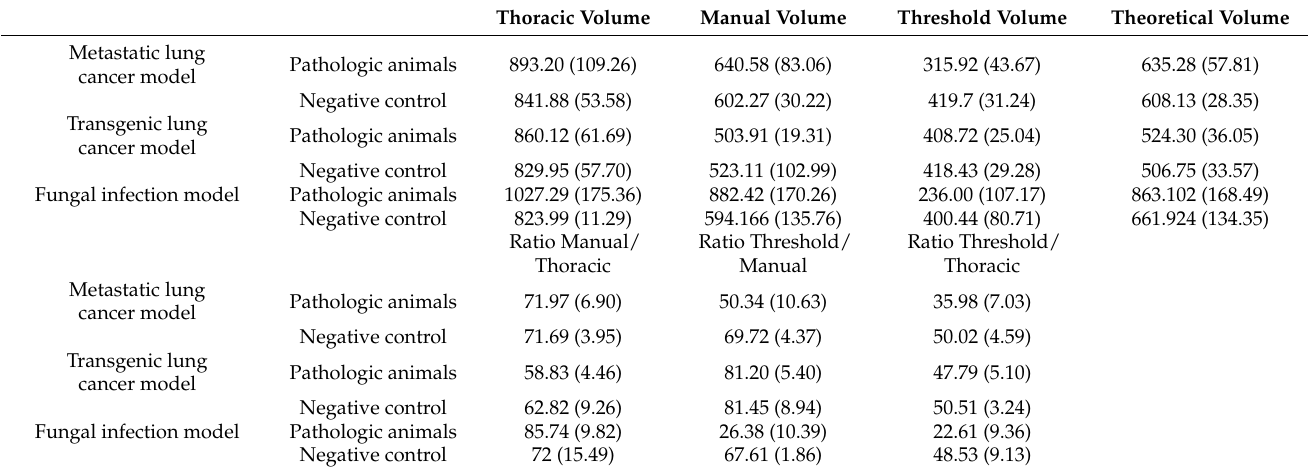
Table 1. Results from pathologic animals in the different groups. Values are in mm 3 and Standard Deviation in brackets.